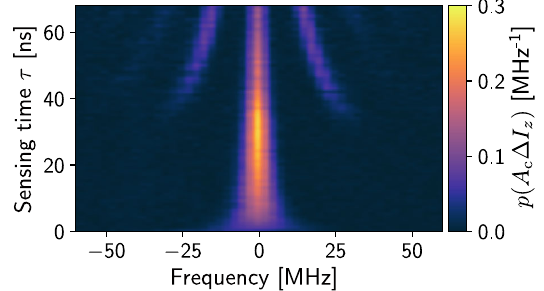
Δ I FIG. 9. Minimum capture range. 2D plot of p ð A z Þ versus c Δ I τ . In this experiment we do frequency, A z , and sensing time c not dynamically sweep the sensing time, but rather use a constant value for all 44 repeats (per preparation cycle) of the